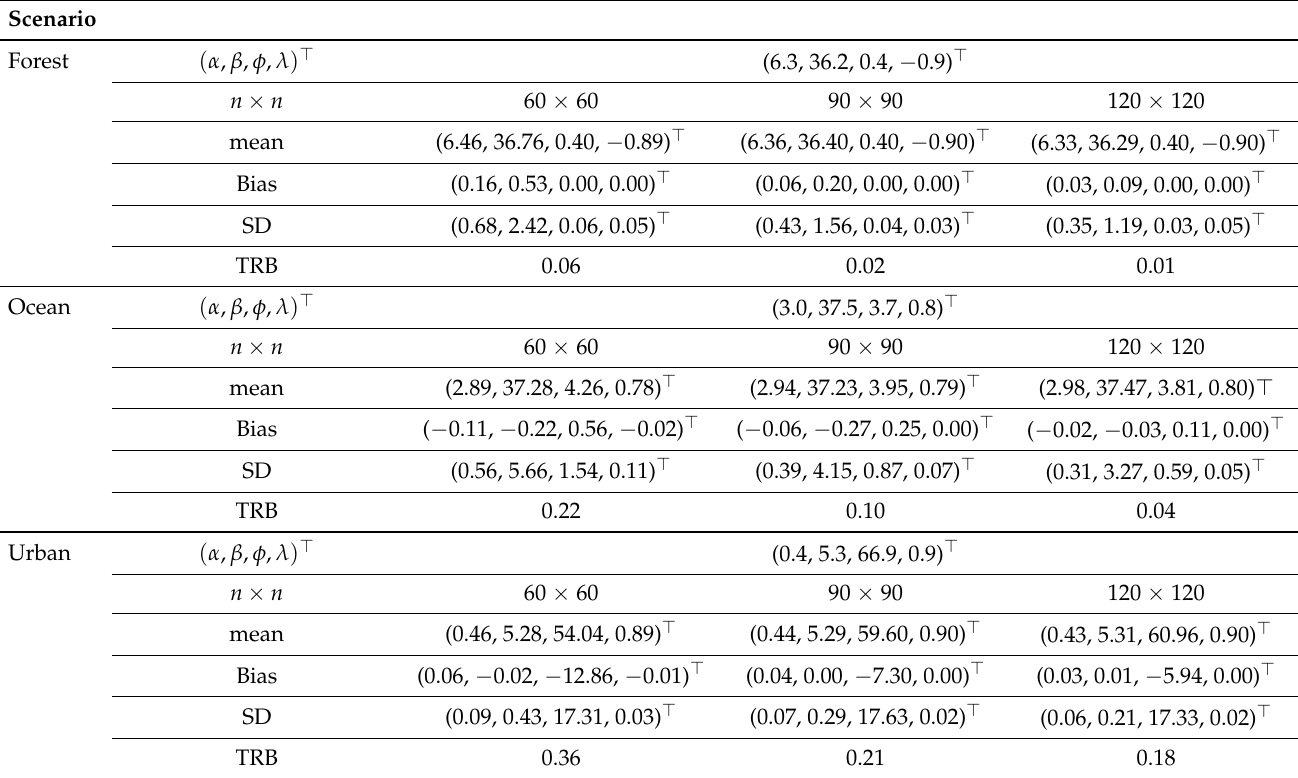
Table 1. Monte Carlo results: mean of maximum likelihood estimates, bias, sd, and